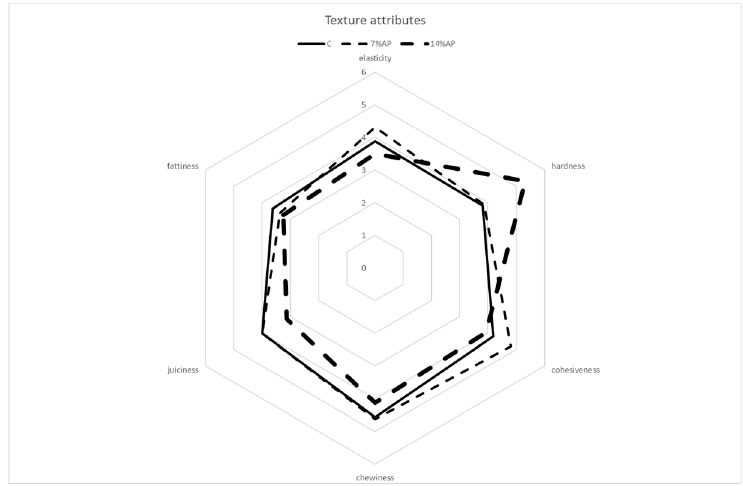
Figure 7. Sensory descriptive analysis. Texture